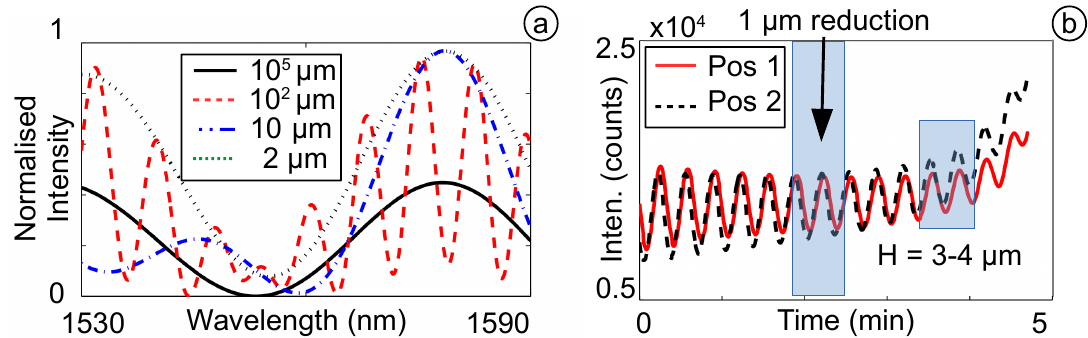
Figure 8. ( a ) FPI spectrum for different diaphragm thicknesses; ( b ) change of intensity during the etching